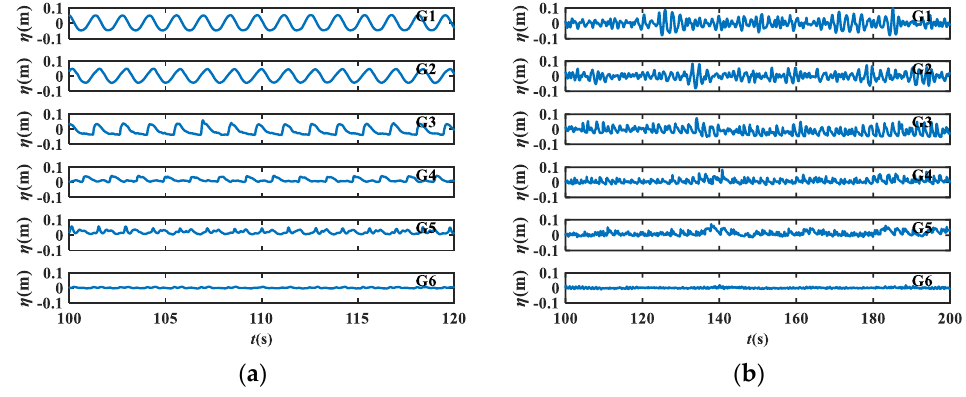
Figure 11. Time histories of free surface elevation for the sloped seawall for H 0 = 0.1 m ( H s 0 = 0.1 m), T 0 = 1.4 s ( T = 1.4 s), cot θ = 3, l = 3 m, h r = 0.05 m: ( a ) regular wave; ( b ) irregular wave.